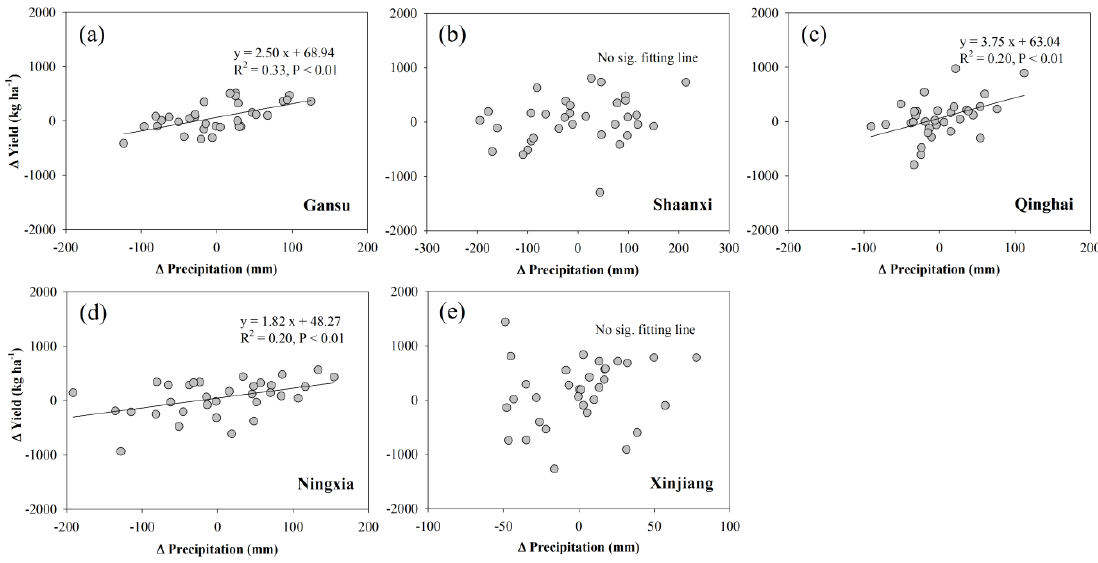
Figure 7. Relationships between changes in the precipitation and potato yield in different provinces of northwest China.